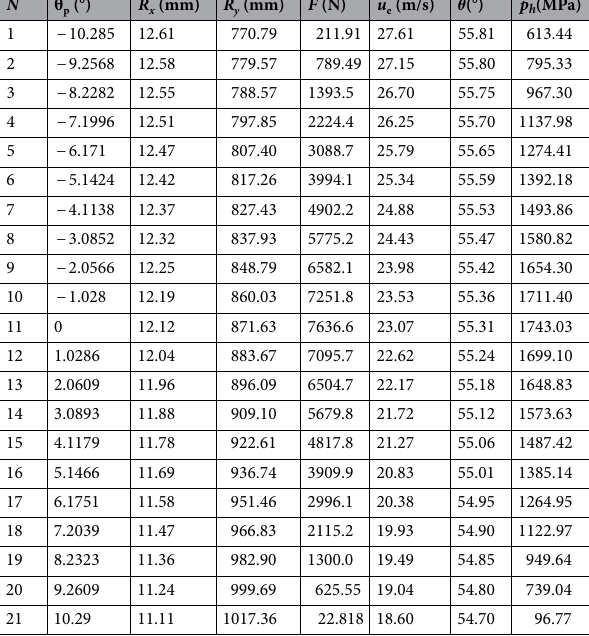
Table 4. Spiral bevel gear’s contact parameters of the meshing point.